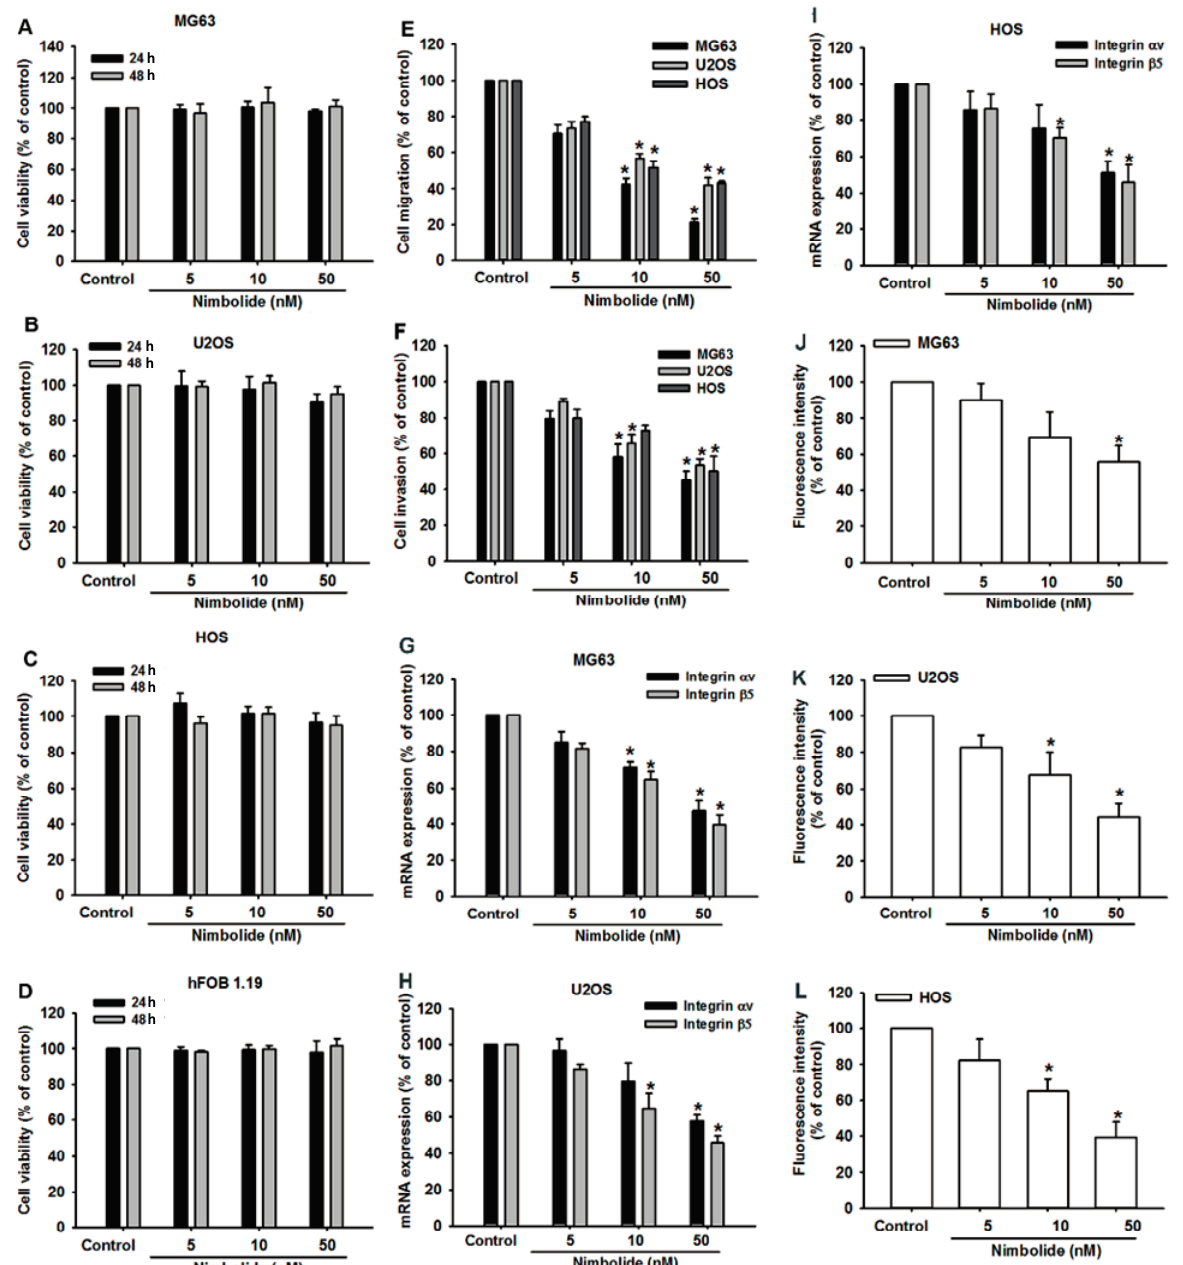
Figure 5. Nimbolide inhibits cell migration of human osteosarcoma cells by modulating the expression of integrin α v β 5. ( A – D ) Osteosarcoma cells (MG63, U2OS, and HOS) and osteoblast cells (hFOB 1.19) were incubated with control solution or various concentrations of Nimbolide for 1 or 2 days, then cell viability was examined by using an MTT assay; ( E , F ) Osteosarcoma cells (MG63, U2OS, and HOS) were incubated with control solution or various concentrations of Nimbolide for 24 h, then migration and invasion were measured in vitro using Transwells; ( G – I ) Osteosarcoma cells (MG63, U2OS, and HOS) were incubated with control solution or various concentrations of Nimbolide for 24 h; The expression of integrin α v and β 5 mRNAs was examined by qPCR ( J – L ). The expression of integrin α v β 5 protein was examined by flow cytometric analysis. The data are expressed as the mean ± SEM. * p < 0.05 compared with